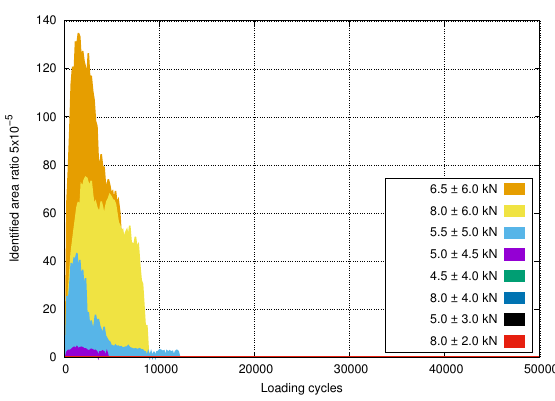
Figure 7. Variation of identified heated area in the vicinity of damage as a function of number of cycles.